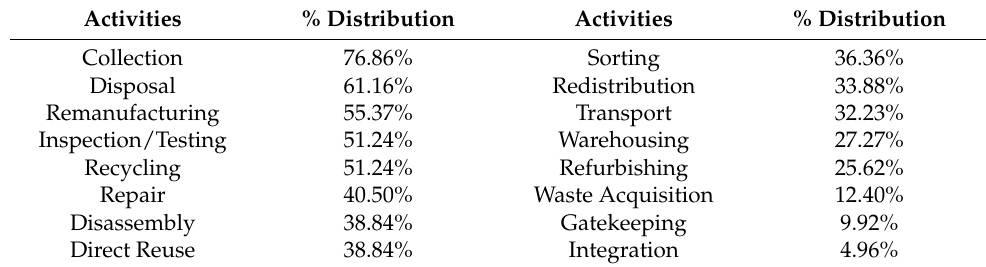
Table 2. Percentage distribution of most-cited RL process activities in the survey.